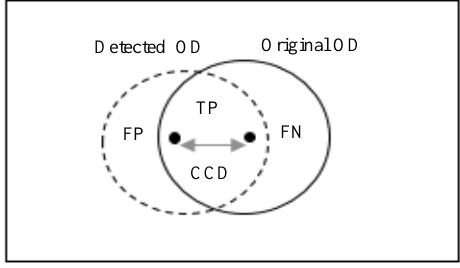
Figure 8. Areas used to estimate performance of proposed method. CDD is Euclidian distance between detected center and original center of optic disc.